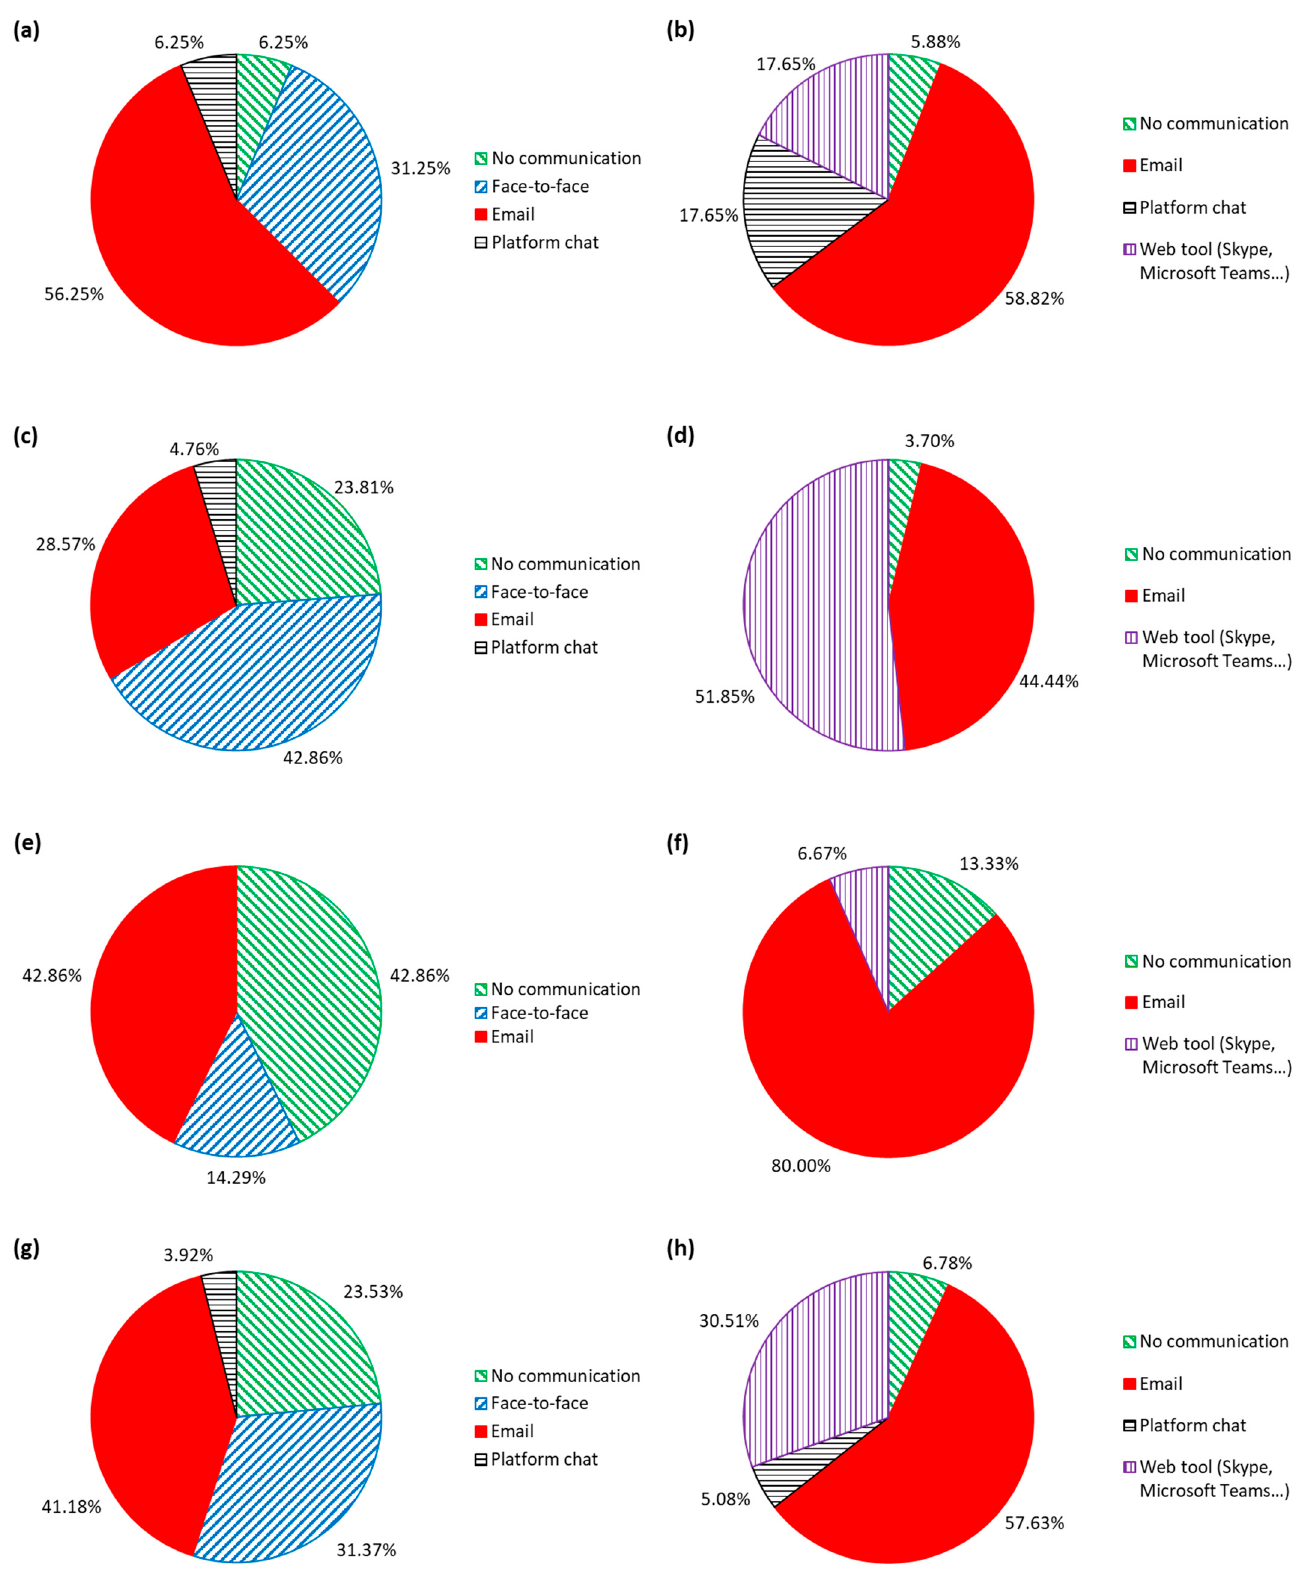
Figure 7. Communication channels of students with teachers: ( a ) BCU, F2F teaching; ( b ) BCU, online teaching; ( c ) DCU, F2F teaching; ( d ) DCU, online teaching; ( e ) MCU, F2F teaching; ( f ) MCU, online teaching; ( g ) All course units together, F2F teaching; ( h ) All course units together, online teaching.